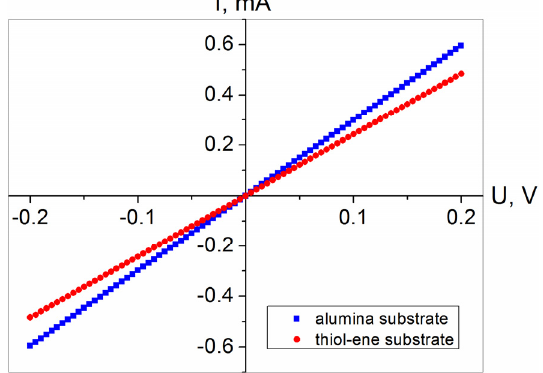
Figure 4. Characteristic current–voltage curves of PEDOT:PSS films on alumina and thiol–ene sub- strates.